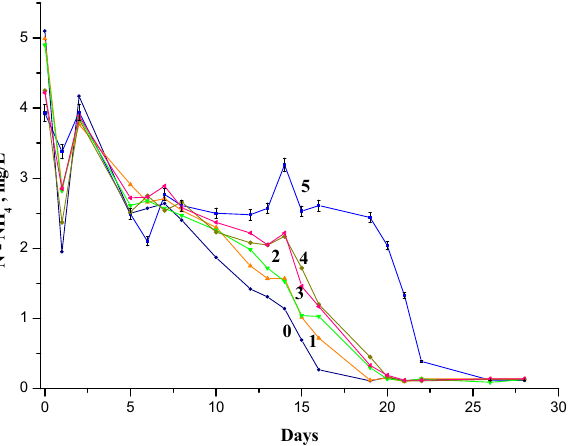
Figure 2. Dynamics of ammonium ions concentration in the Nistru River water containing 6 mg/L NH 4+ in the presence of 1-naphthylamine: (0) 0 mg/L, reference sample; (1) 0.025 mg/L (0.5 MAC of 1-NA); (2) 0.05 mg/L (1.0 MAC of 1-NA); (3) 0.1 mg/L (2.0 MAC of 1-NA); (4) 0.25 mg/L (5 MAC of 1-NA); (5) 0.5 mg/L (10 MAC of 1-NA).